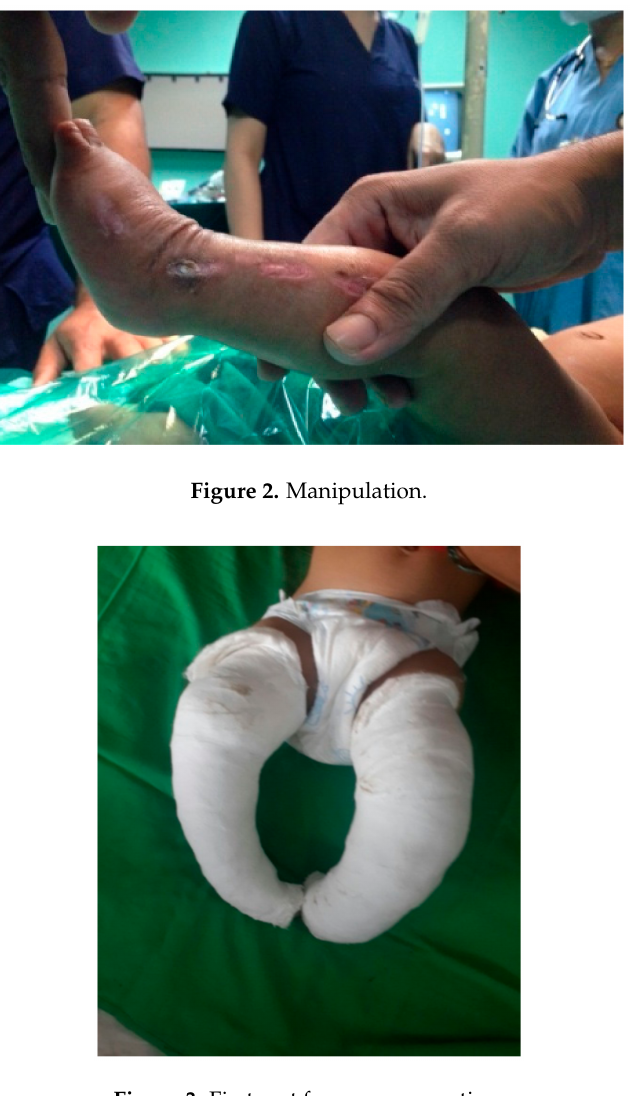
Figure 3. First cast for cavus correction.